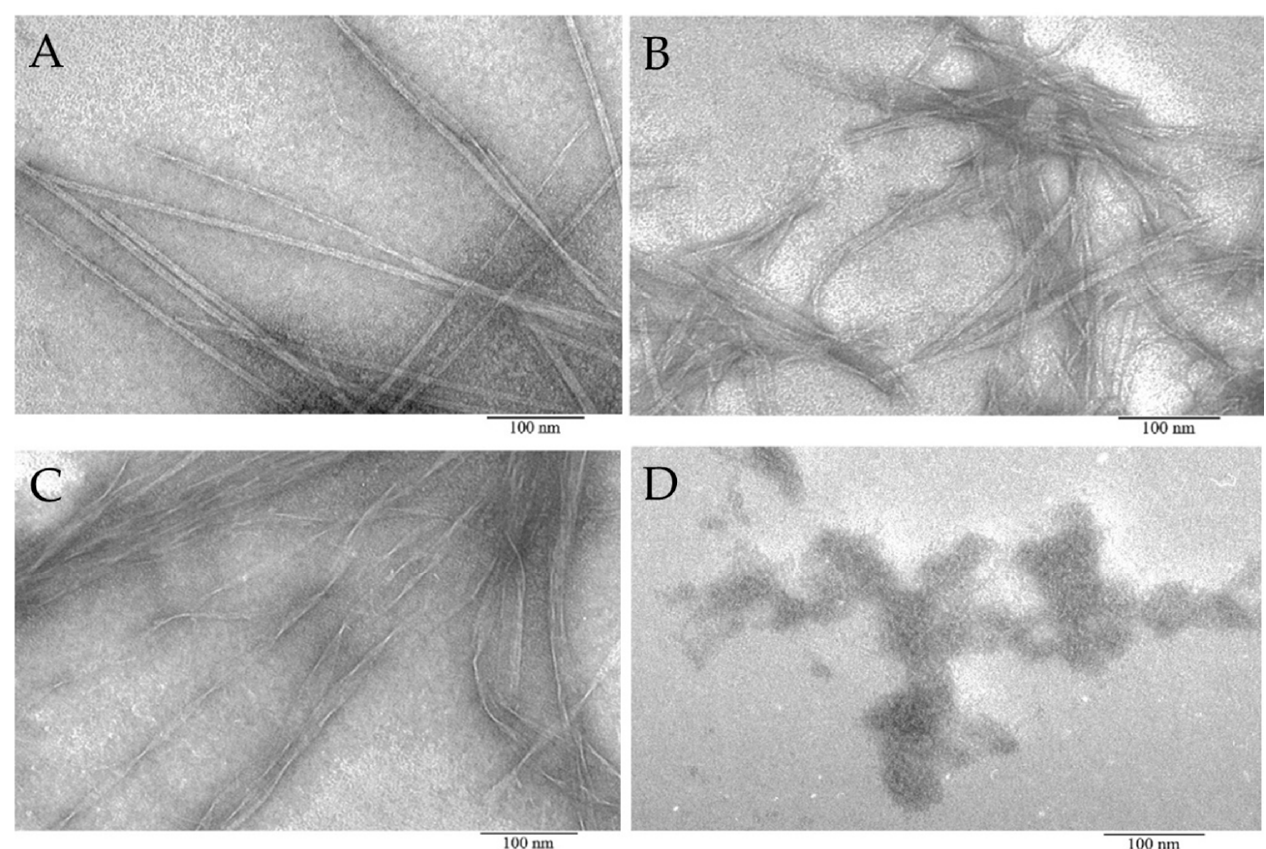
Figure 3. Electron microscopic images of aggregates formed from peptide preparations synthesized based on the bPaS1 sequence: AIITGIVVDI ( A ), SWIVLEAAFA ( B ), ITDFGIFIGL ( C ), and disordered aggregates of the LHITDMAWKR peptide ( D ).